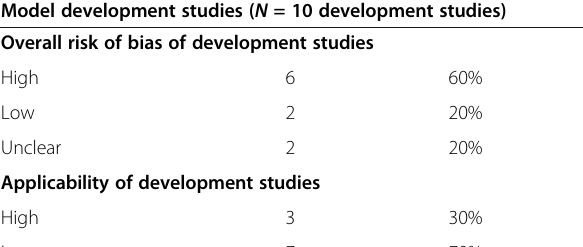
Table 2 Overview of risk of bias, applicability, usability, and similarity in study design of development and validation studies Model development studies ( N = 10 development